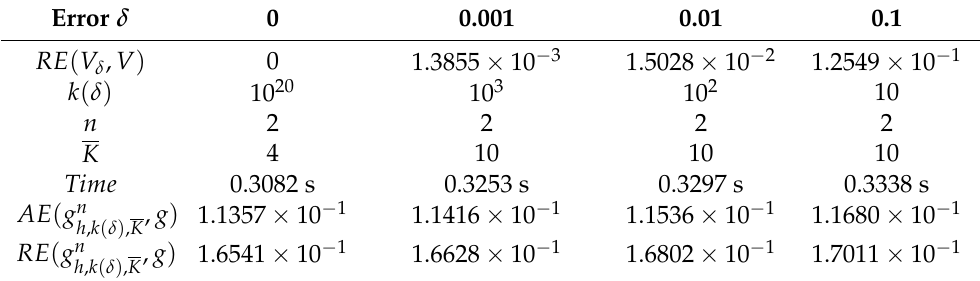
Figure 7. ( a ) Plots of exact normal derivative of u 1 and its approximations with and without sequential smoothing corresponding to input data without error V , using mesh M 1 of irregular region. ( b ) Plots of exact normal derivative of u 2 and its approximations with and without sequential smoothing corresponding to input data without error V , using mesh M 1 of irregular region. Table 4. Convergenceofnumericalresultsforirregularregionwithnoisydata V δ usingmesh M 1 ( 855,1607 ) and ε = 10 − 3 .